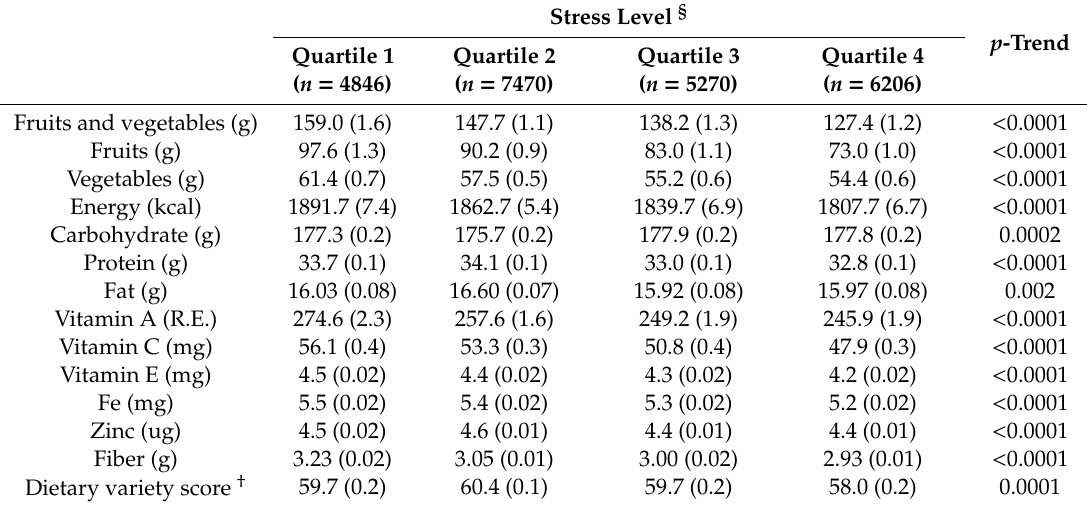
Table 3. Dietary intake status of the participants according to quartile of stress